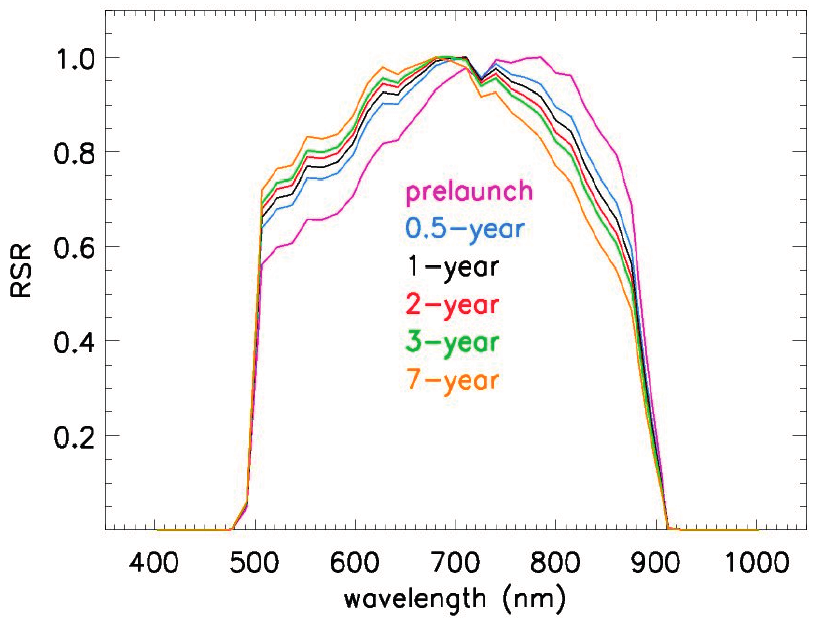
Figure 2. Modulated relative spectral responses (RSRs) computed based on current and projected rotating telescope assembly (RTA) mirror degradation trends at selected time